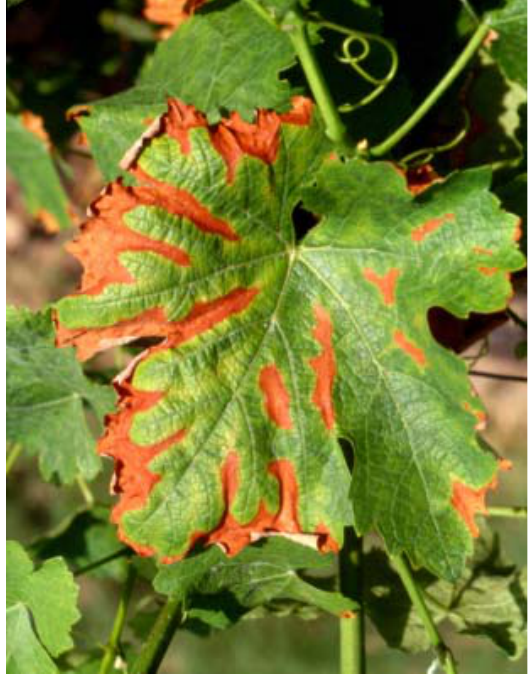
Fig. 3. Foliar symptoms of the mild form of black dead arm on Sauvignon.